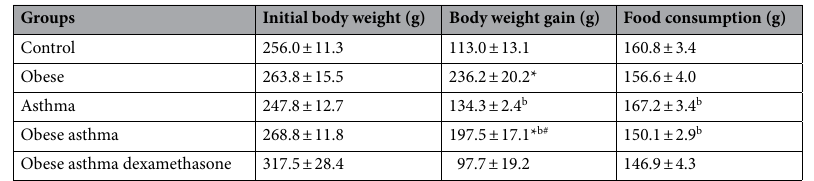
Table 2. Initial body mass values, body mass gain and food intake of rats from the Ctrl, Ob, Asth, Ob + Asth and Ob + Asth + Dexa. One-way ANOVA followed by Tukey’s posttest (n = 4–6). * p < 0.05 (Ctrl vs. Ob, Ob + Asth), b p < 0.05 (Asth vs. Ob + Asth); # p < 0.05 (Ob + Asth + Dexa vs. Ob + Asth).